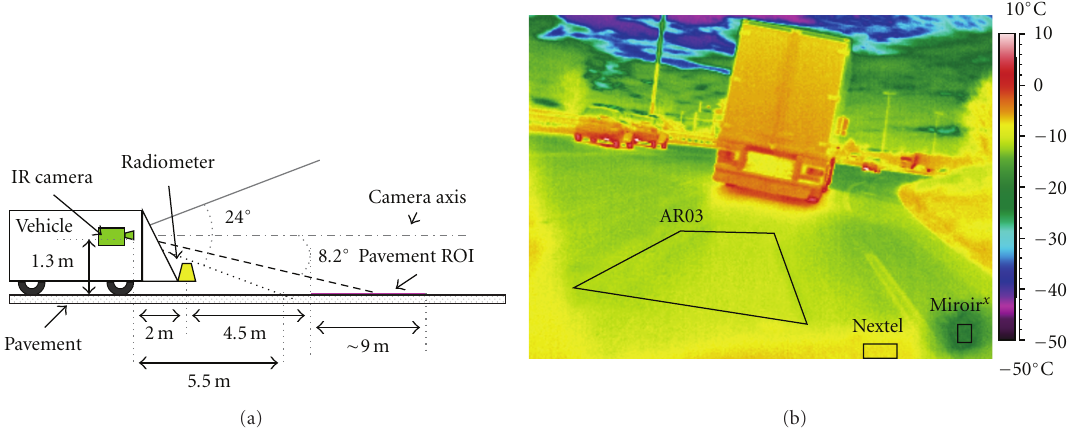
Figure 2: Sketch of instruments configuration (a) and thermal image from the vehicle with ROI (b).